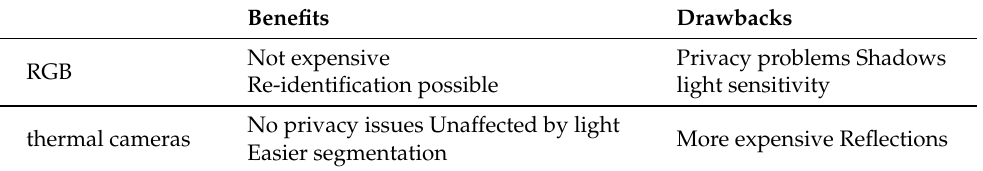
Table 1. The benefits and drawbacks of utilizing RGB and thermal cameras to detect and track